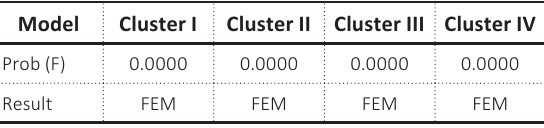
Table 4. The Hausman test on the panel regression model